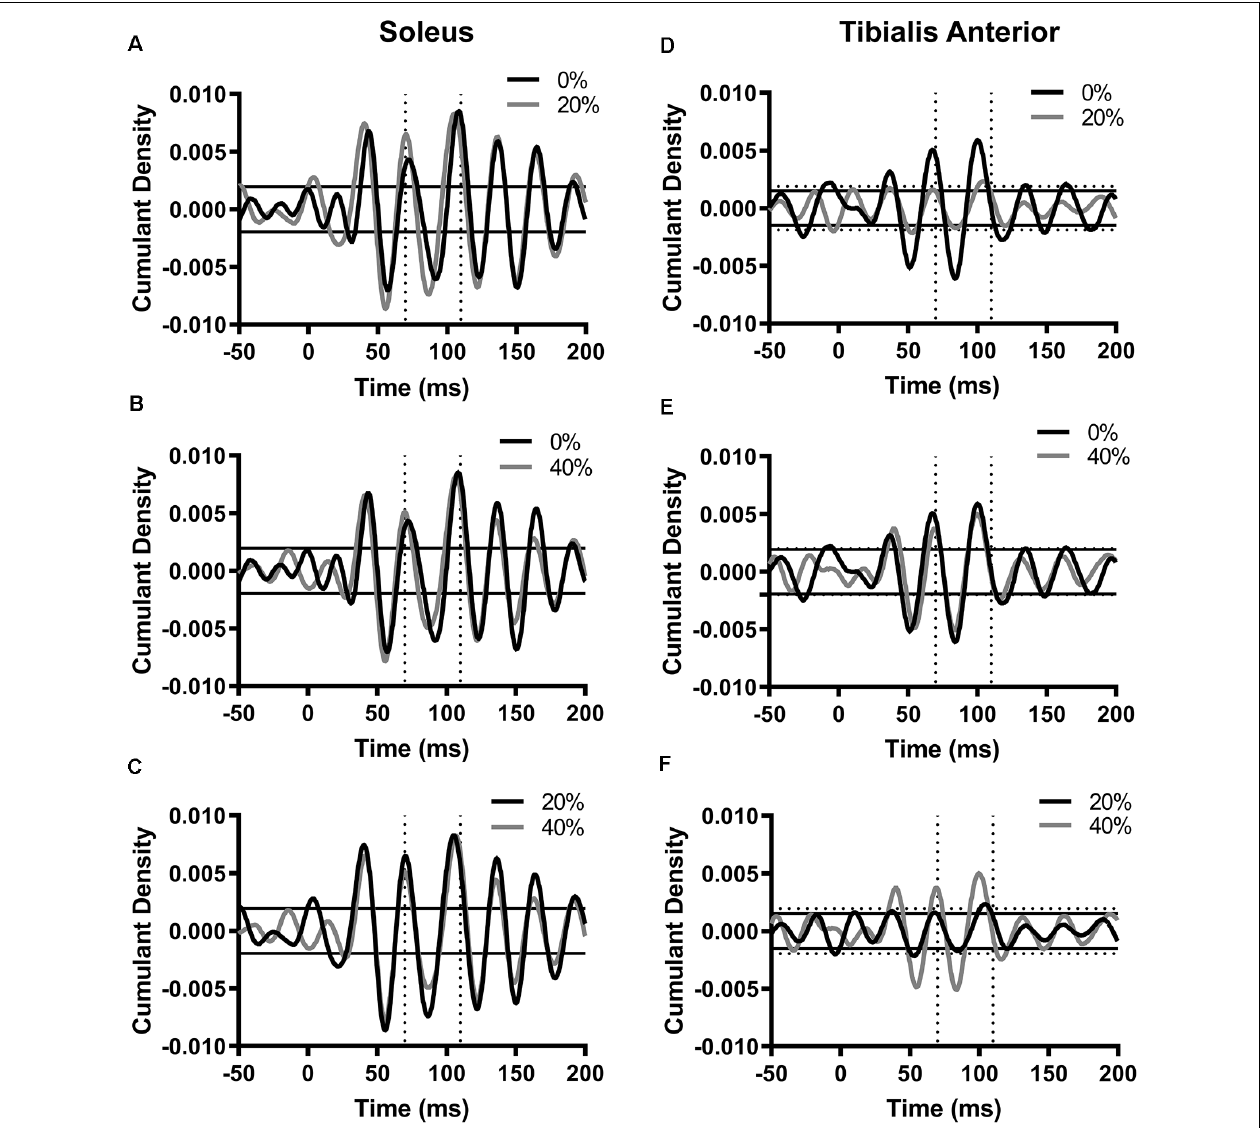
FIGURE 2 | Cumulant density functions generated between probe acceleration and soleus EMG (A–C) or tibialis anterior EMG (D–F) . Horizontal lines represent 95% confidence interval bounds for the 0% PT condition. In figures (D–F) , solid horizontal lines represent confidence intervals for the cumulant density function in the 20% noise condition (D,F) or 40% noise condition (E) . Dotted horizontal lines represent confidence intervals for the cumulant density function in the 0% noise condition (D) or 40% noise condition (E,F) . For all cumulant densities, peak-to-peak (PTP) amplitudes for each function were calculated between 70–110 ms (indicated by the vertical broken lines). The number of segments: SOL, 3,515 disjointed segments; TA, 2,929 disjointed segments. Segment length = 0.8192 ms, time resolution: 0.02